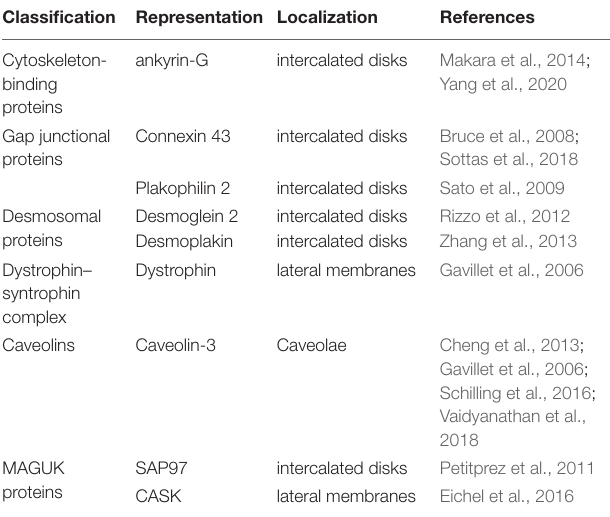
TABLE 2 | Protein partners associated with Na V 1.5 localization in the cardiomyocytes. Classification Representation